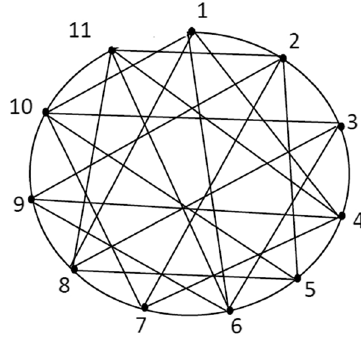
Fig. 10 | D 1 | = n = 11, m = 2